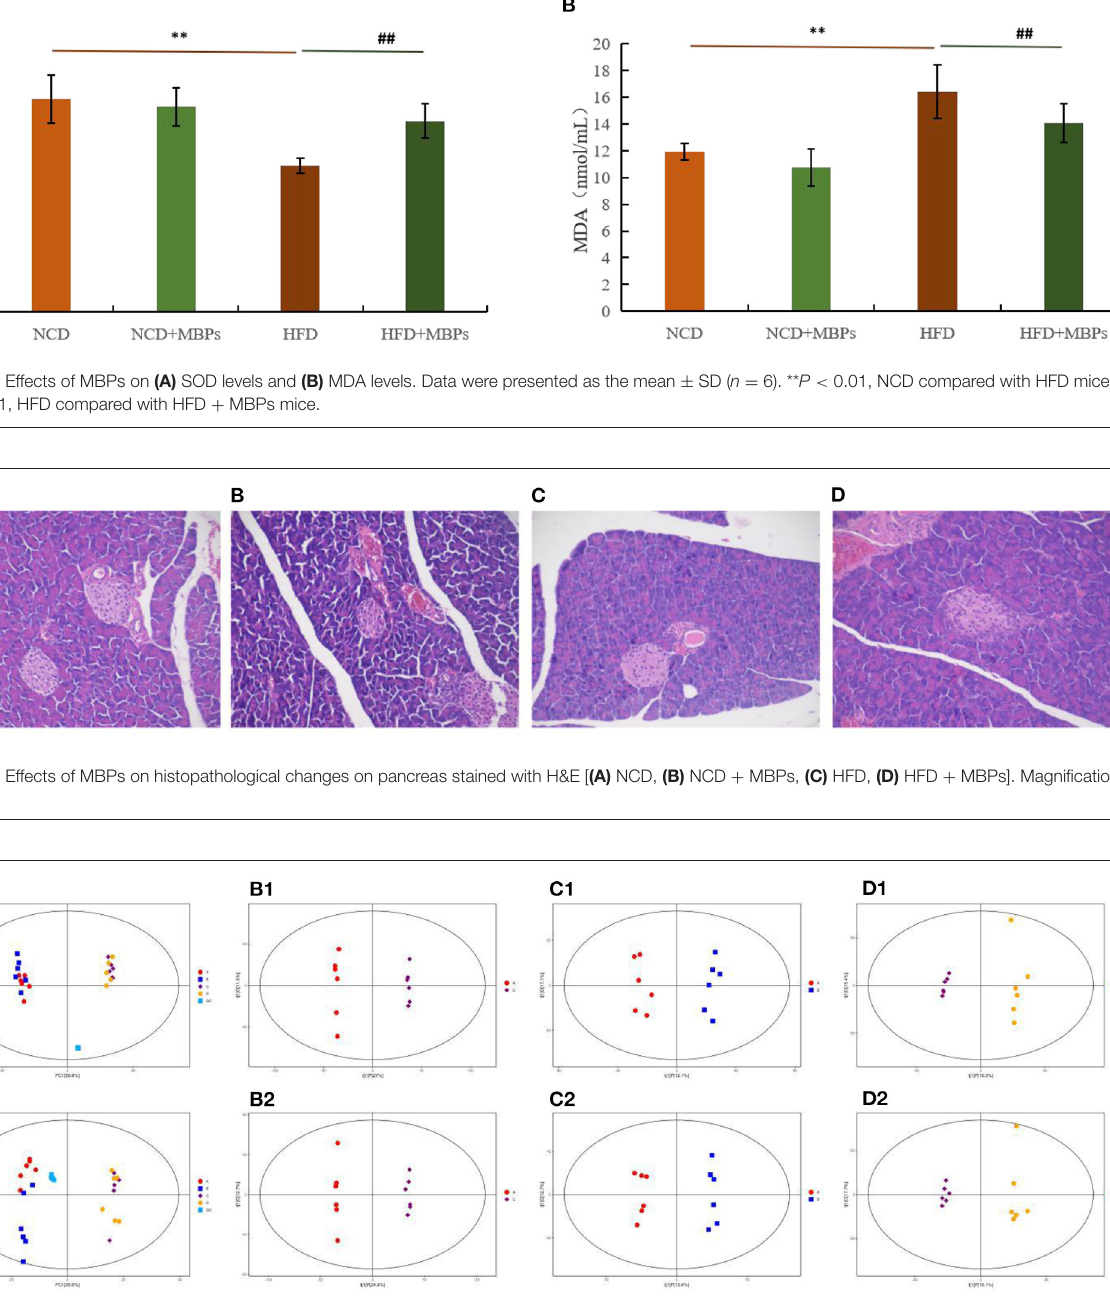
FIGURE 8 | PCA score plots of the QC, NCD, NCD + MBPs, HFD, and HFD + MBPs groups in (A 1 ) NEG and (A 2 ) POS ion modes; OPLS-DA analysis of serum of mice. Score scatter plot of OPLS-DA model for the group NCD vs. HFD [ (B 1 ) NEG ion, (B 2 ) POS ion], NCD vs. NCD + MBPs [ (C 1 ) NEG ion, (C 2 ) POS ion], HFD